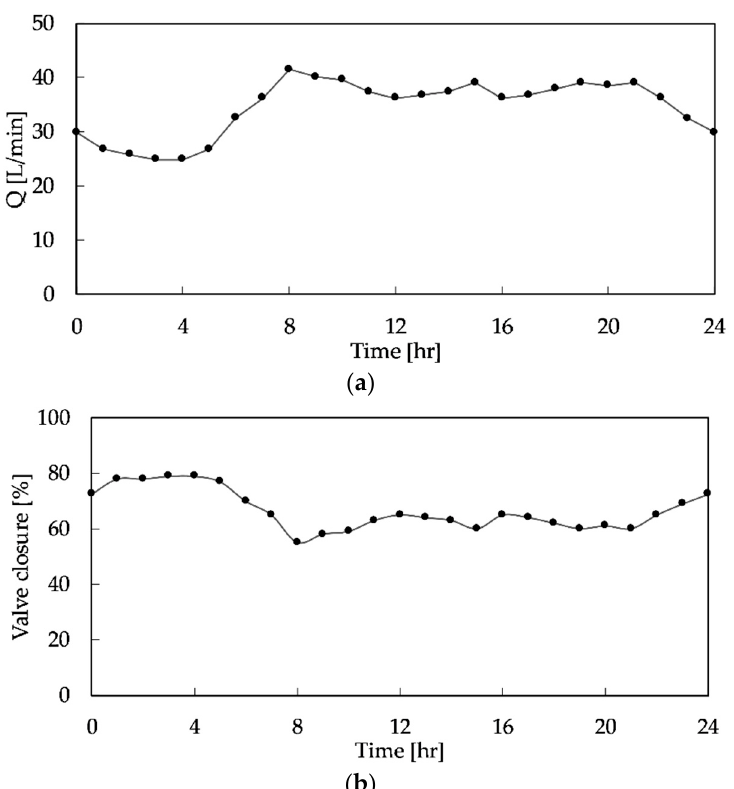
Figure 14. A real system pattern: ( a ) flow rate pattern; ( b ) valve closure pattern.